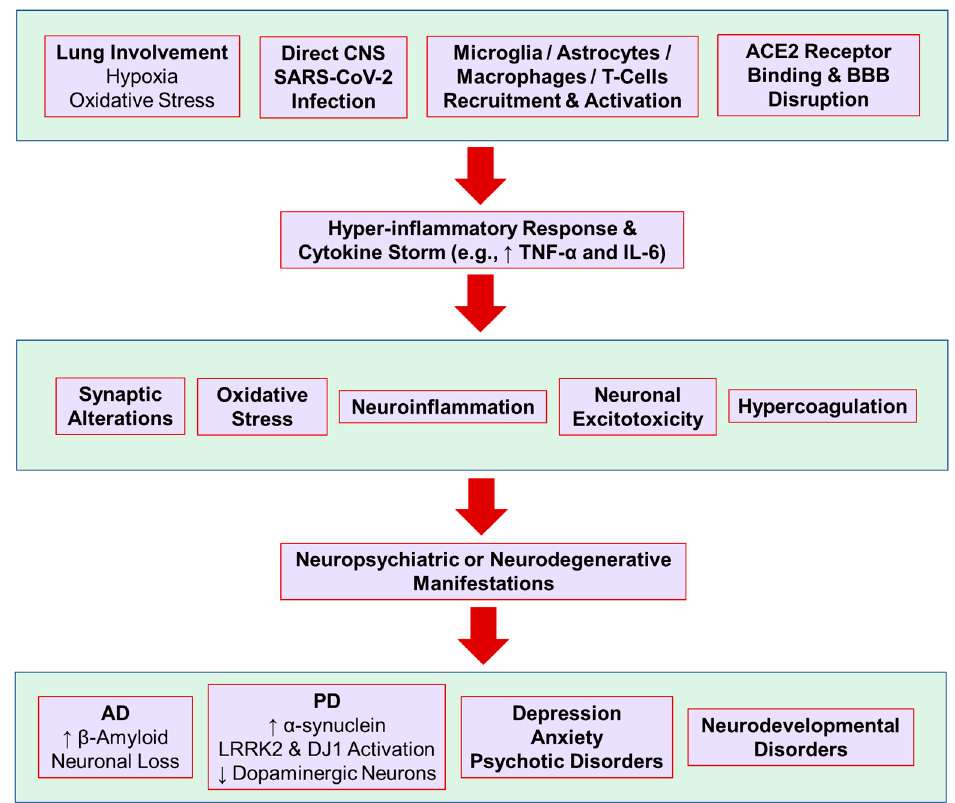
Figure 1. Neuropsychiatric manifestations and possible underlying mechanisms after SARS-CoV-2 infection. ACE2, angiotensin-converting enzyme 2; AD, Alzheimer’s disease; BBB, blood-brain barrier; IL-6, interleukin-6; LRRK2, leucine-rich repeat kinase 2; PD, Parkinson’s disease; TNF- α , tumor necrosis factor- α .